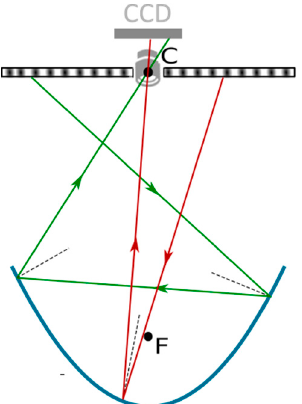
Figure 2. Example of double reflection in an m-PTC for a hypothetical application of deflectometry. F is the focal point of the parabola; C represents the entrance aperture of the camera lens.